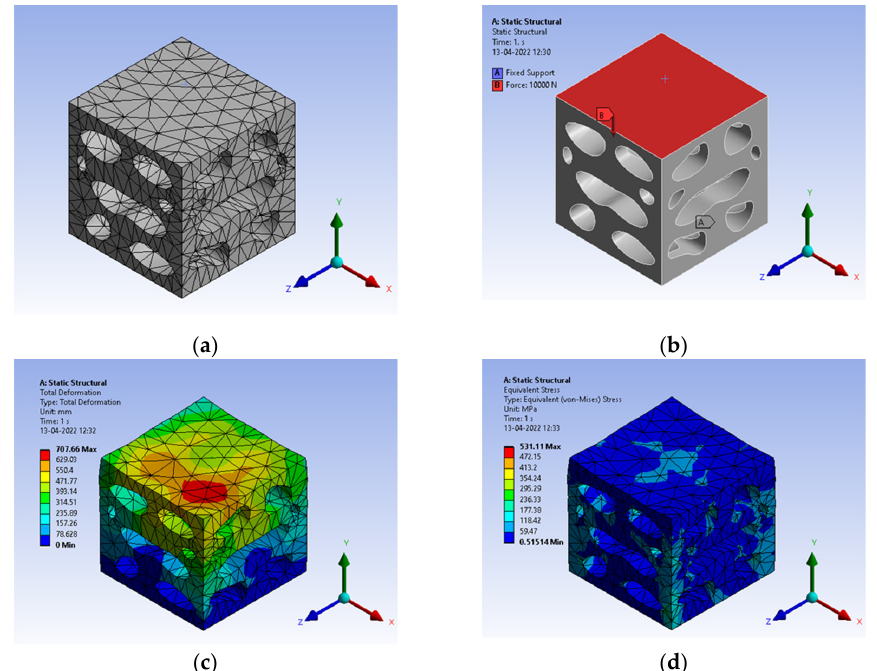
Figure 18. ( a ) Mesh generation; ( b ) Loads and boundary conditions; ( c ) Total deformation; ( d ) Von mises stress.